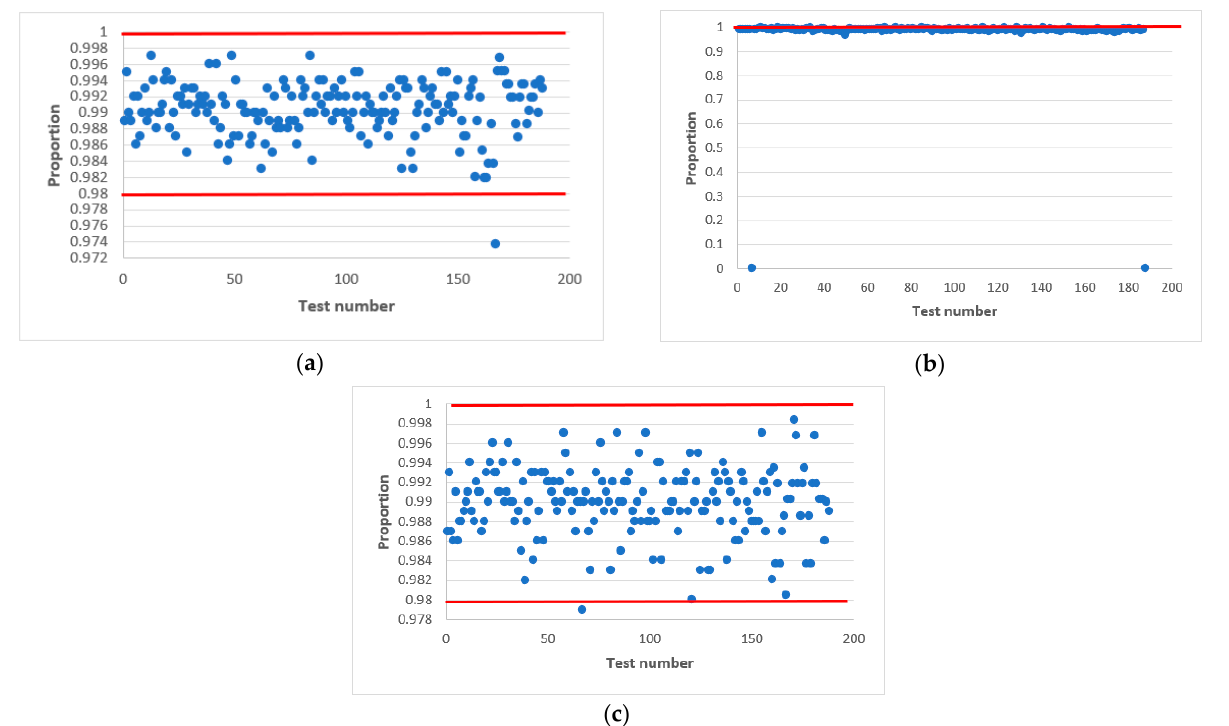
Figure 7. Statistical portrait of the MAFG output sequence for h = 8, a = a 0 ⊕ a 1 with initial values: .